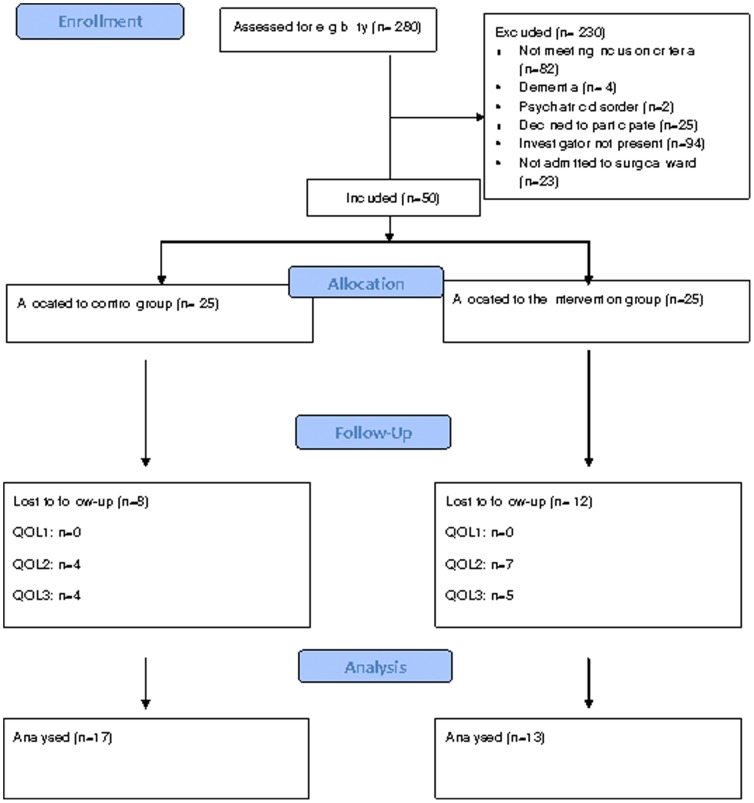
Consort 2010 Flow diagram.